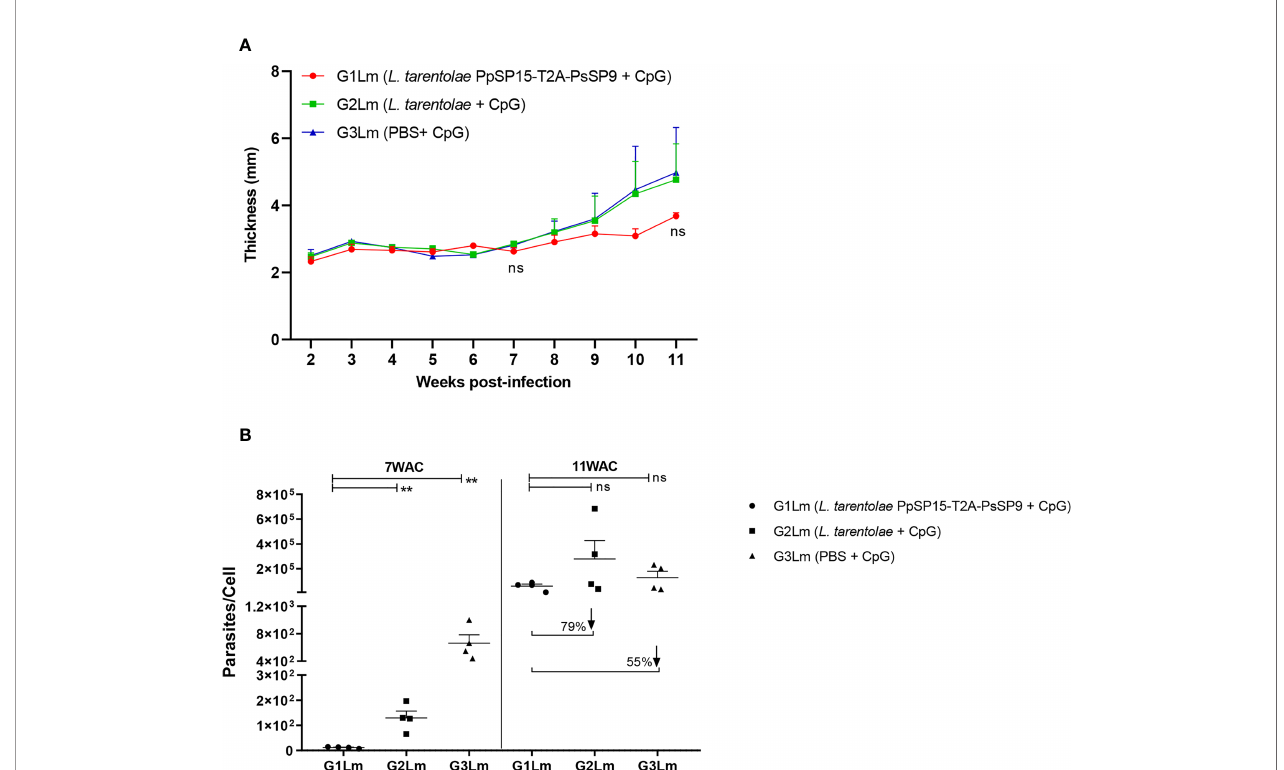
FIGURE 4 | Assessment of footpad thickness and parasite load in vaccinated and control BALB/c mice infected with L. major +SGH. Pre-treated BALB/c mice (n=28 per group) with CpG were immunized at the left footpad with L. tarentolae PpSP15-T2A-PsSP9 (G1), L. tarentolae (G2), and PBS (G3). Three weeks after the last booster, mice were challenged with L. major metacyclic promastigotes plus Ph. papatasi SGH in the contralateral footpad. (A) The in fl ammation progression was monitored weekly by measuring footpad thickness. Data are representative of two independent experiments. Results are exhibited as the mean ± SE and student t- test was used for statistical analysis ( p -value < 0.05 as signi fi cant, ns, non-signi fi cant). (B) The number of parasites per mouse lymph node cell was determined at weeks 7 and 11 post-infection by Real-Time PCR (n=4 mice per group). Results are exhibited as the mean ± SE. Data are representative of two independent experiments. Student t-test was used for statistical analysis (** p < 0.01; ns, non-signi fi cant). The arrows show the percentage reduction of parasite load in G1Lm in respect to control groups at week 11 after infectious